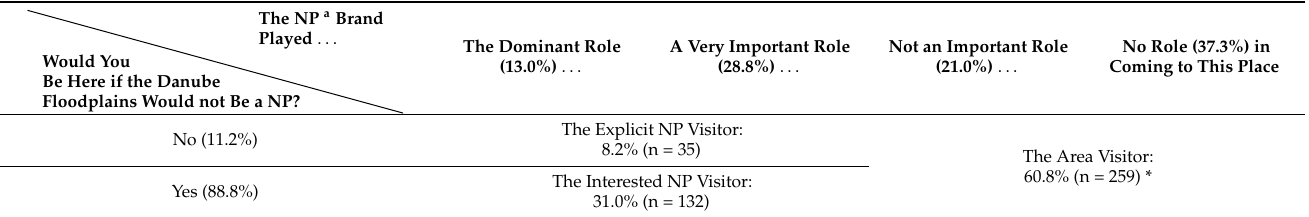
Table 1. Definition of national-park affinity segments with segment sizes (n =